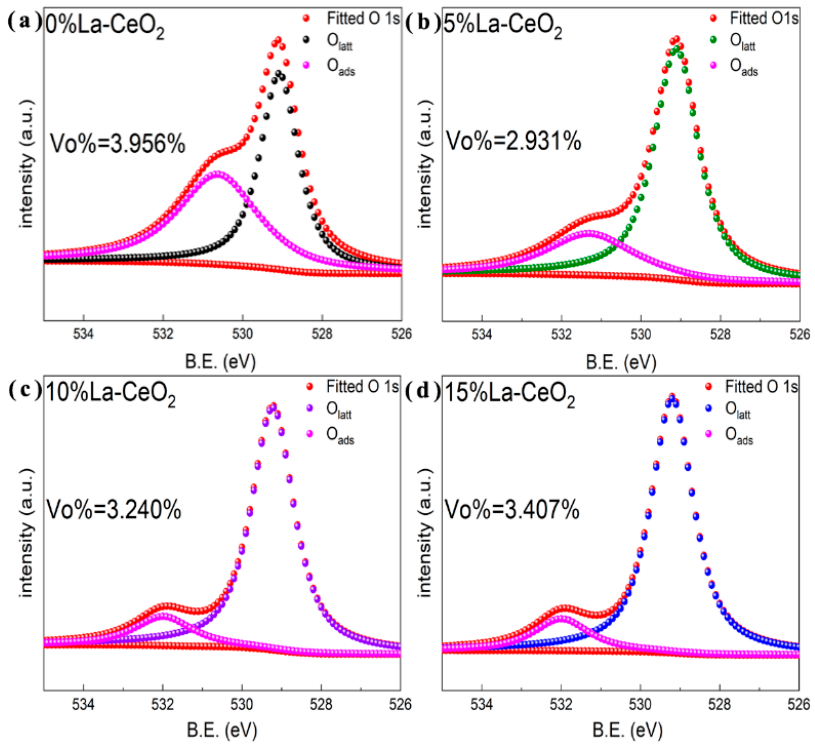
Figure 4. XPS of oxygen in cerium oxide doped with lanthanum at different concentrations: ( a ) 0% La-CeO 2 , ( b ) 5% La-CeO 2 , ( c ) 10% La-CeO 2 and ( d ) 15% La-CeO 2 .